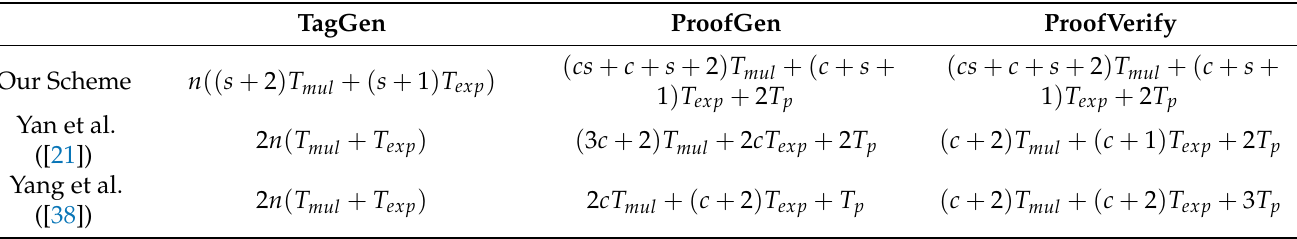
Table 2. Comparison of computational cost.